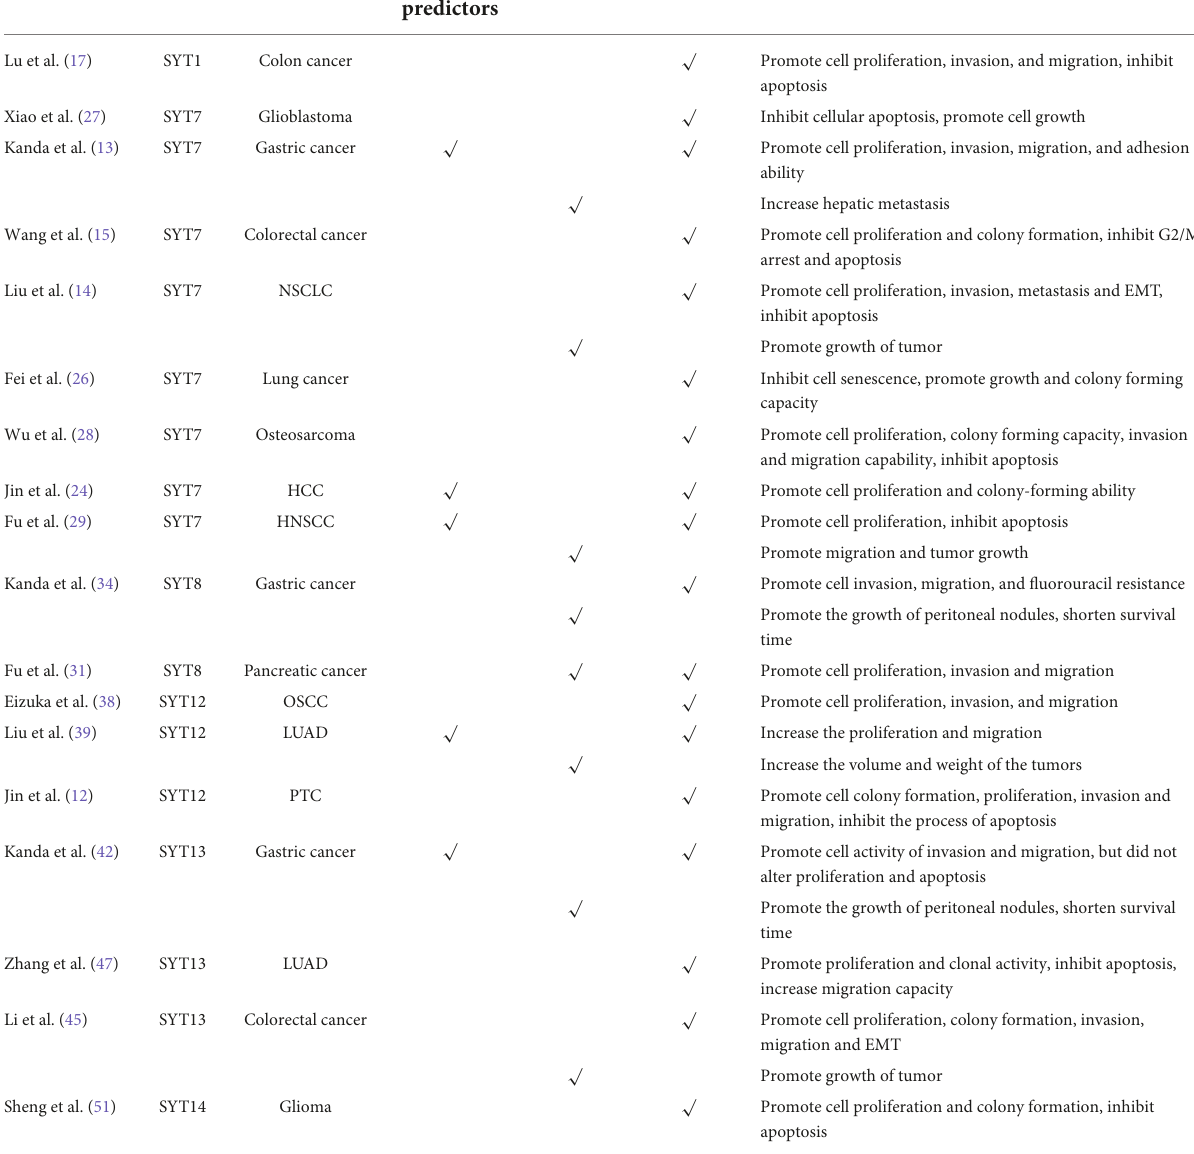
TABLE 1 Potential functions of SYTs in